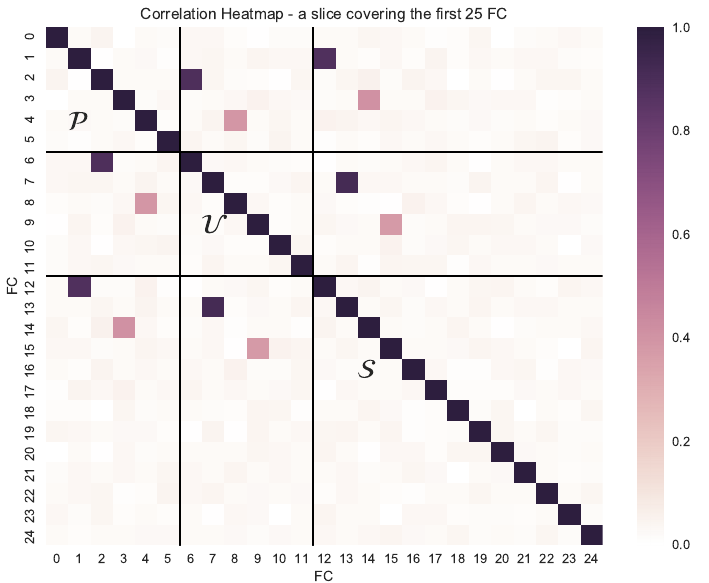
Figure 1. The figure displays a fraction of the default correlation matrix used for the simulations. It shows the correlation for the first 25 FC, where FC 0 to 5 refer to the set of FC with positive risk-premia, 6-11 belong to U and the rest to S . For example, FC 1 (part of P ) and FC 12 (part of S ) are correlated with each other with a correlation of around 0.9. Note that the missing 75 FC are uninteresting insofar as their off-diagonal elements are close to